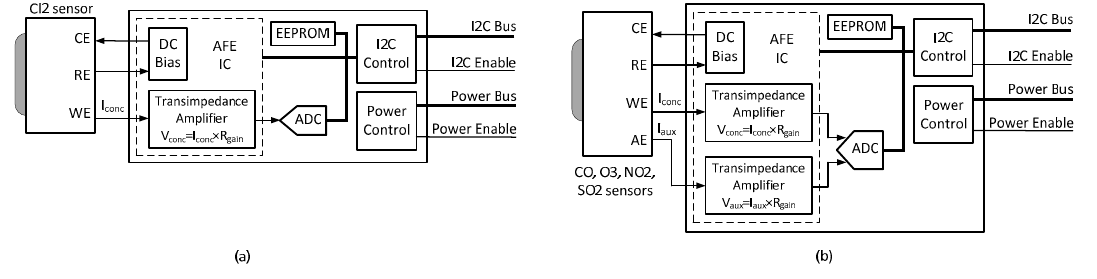
Figure 4. Block diagrams of the interface modules for the: three-electrode ( a ); and four-electrode ( b )